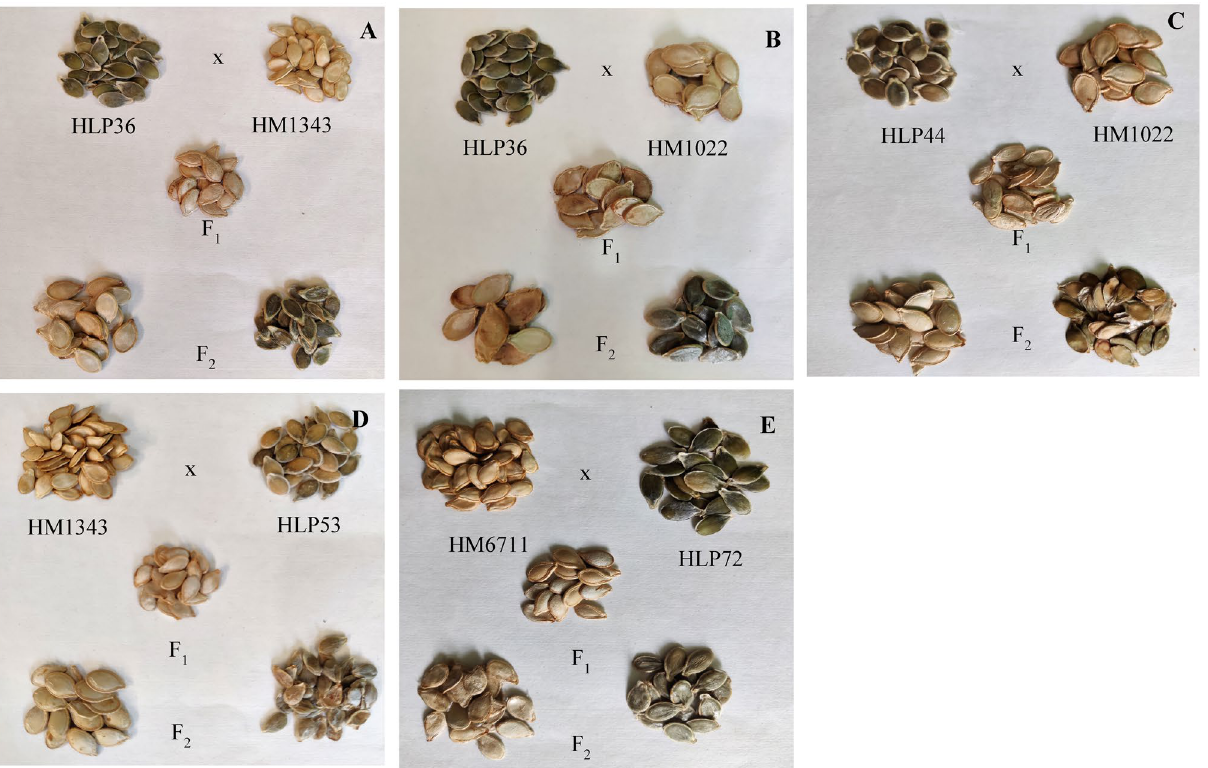
Figure 3. Representing phenotype of seeds used in the study. ( A ) Family I (HLP36 x HM1343), ( B ) Family II (HLP36 x HM1022), ( C ): Family III (HLP44 x HM1022), ( D ) Family IV (HM1343 x HLP53), ( E ) Family V (HM6711 x HLP72); F 1 : Interspecific F 1 hybrid of respective cross; F 2 : Hulled and hull-less representatives of F 2